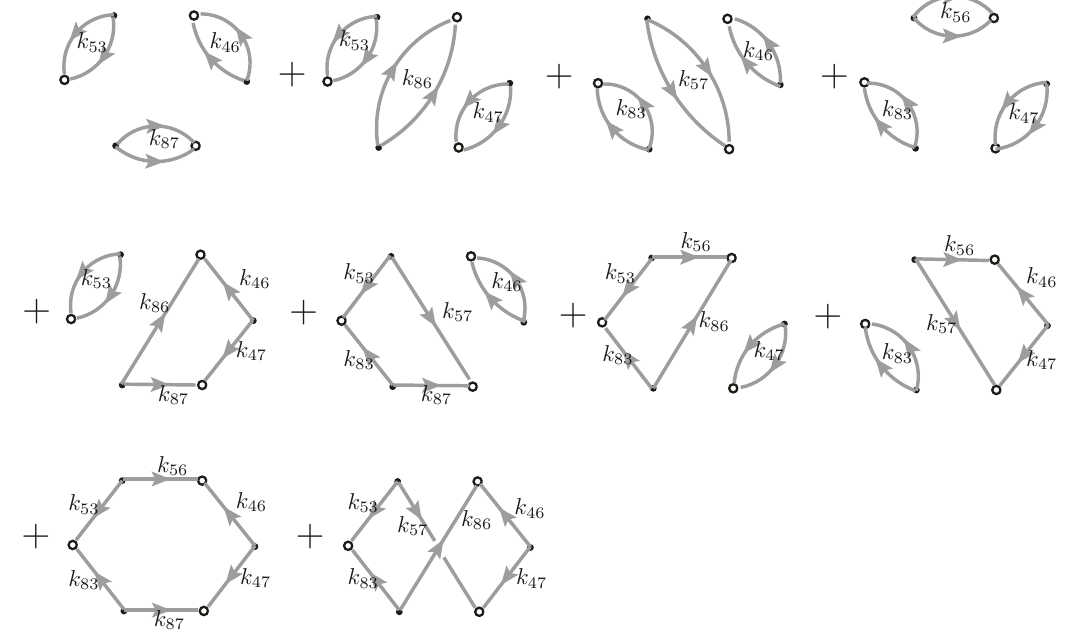
Figure 14 . The paths corresponding to non-vanishing contributions to the integral encoded in the diagram of (cid:12)gure 12. Note that all cycles of length two are actually accompanied by a factor of 1 = 2 which, however, we did not write in the (cid:12)gure to avoid clutter.